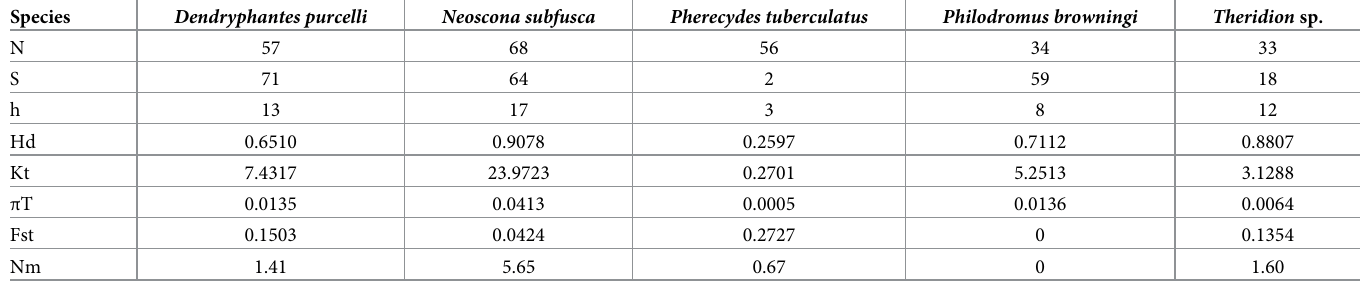
Table 1. Total diversity indices of the five investigated spider species from populations in the Golden Gate Highlands National Park, calculated from nucleotide sequence of mitochondrial COI gene.